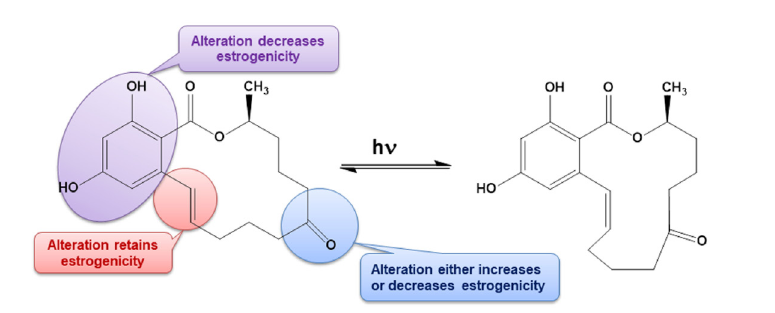
Figure 1: Structure of cis (a) and trans (b) zearalenone